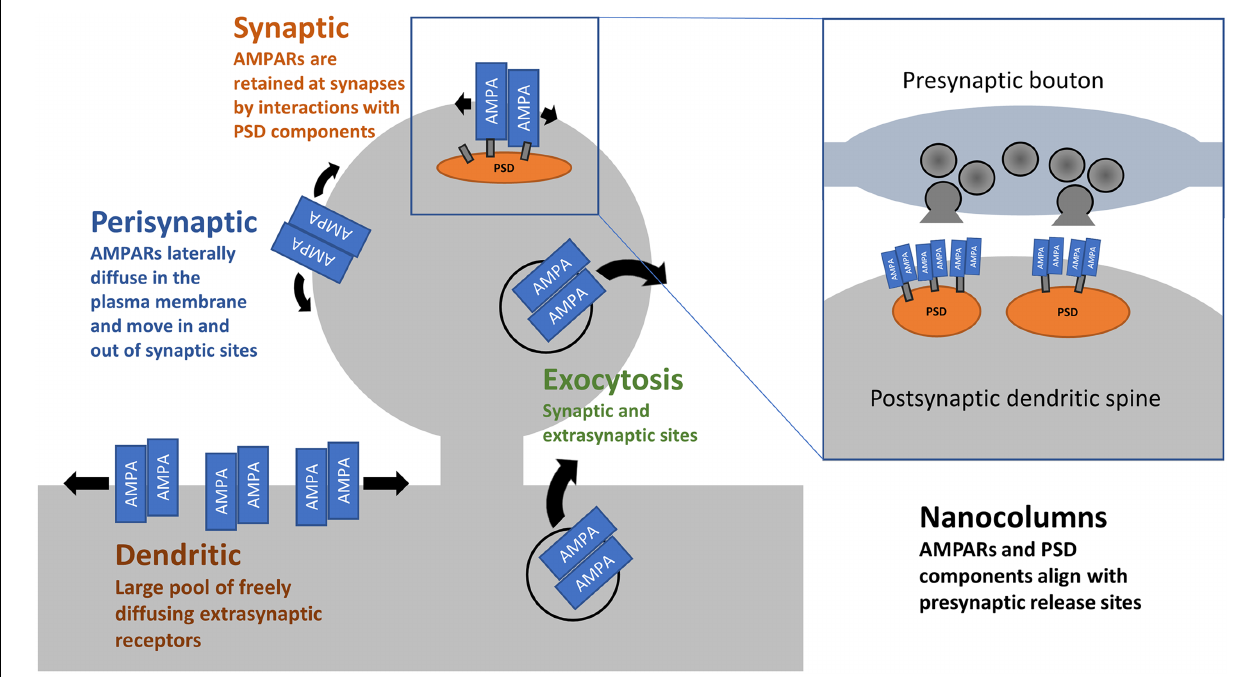
FIGURE 1 | AMPAR trafficking and distribution. AMPARs arrive at the cell surface through exocytosis at dendritic, presynaptic, and synaptic sites. This is both constitutive and triggered by activity. Once on the cell surface, AMPARs are free to laterally diffuse in the plane of the plasma membrane. At synaptic sites, interactions between AMPARs, their accessory proteins, and PSD components act to retain receptors. Within synapses, there is precise alignment between postsynaptic AMPARs and the presynaptic release